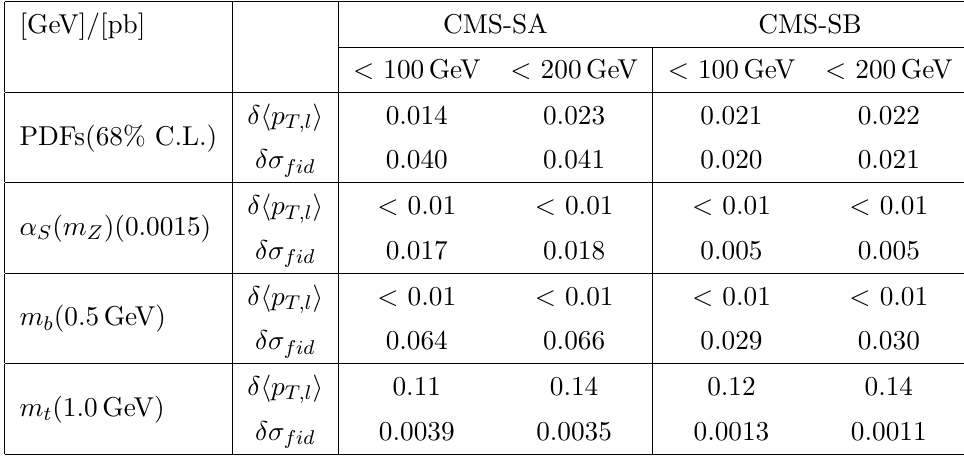
Table 3 . PDF uncertainties on the average transverse momentum of the charged lepton and on the fiducial cross section within the two fiducial regions, followed by induced changes on the same quantities when varying α S ( m Z ) , m b , and m t by the amount in